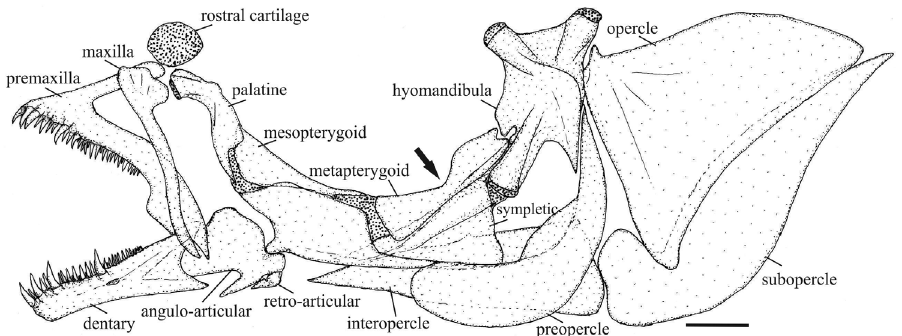
Figure 10. Jaws, jaw suspensorium and opercular apparatus, left side, lateral view, of Melanorivulus ignescens , paratype, UFRJ 6877, 25.1 mm SL. Larger stippling indicates cartilage. Scale bar: 0.5